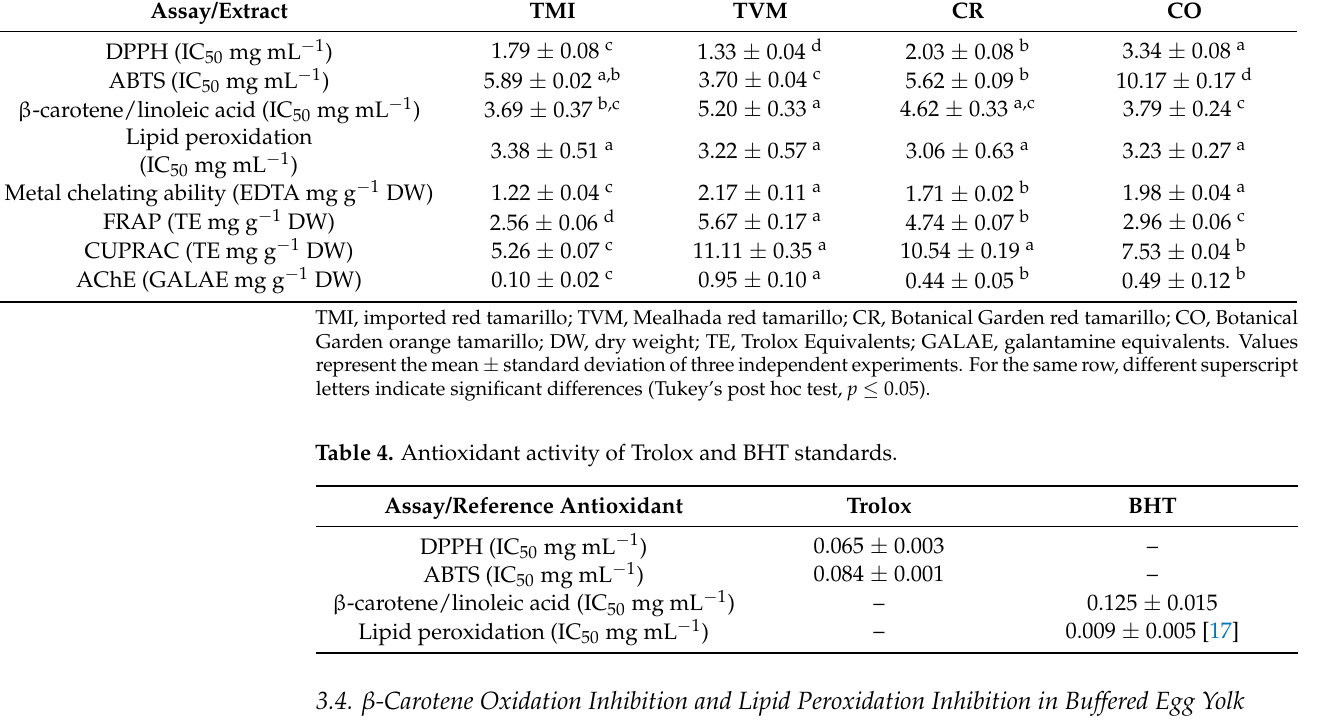
Table 3. Antioxidant and enzymatic activities of the different tamarillo genotypes presently studied. Assay/Extract